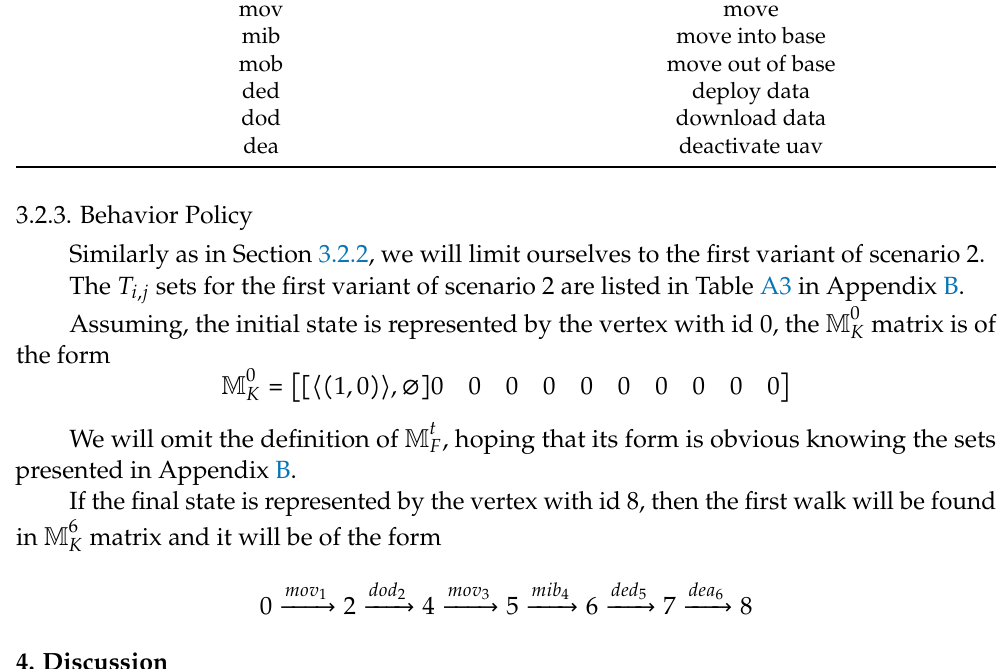
Table 6. A mapping of system changes labels to corresponding reaction rules. Label of A Change in A